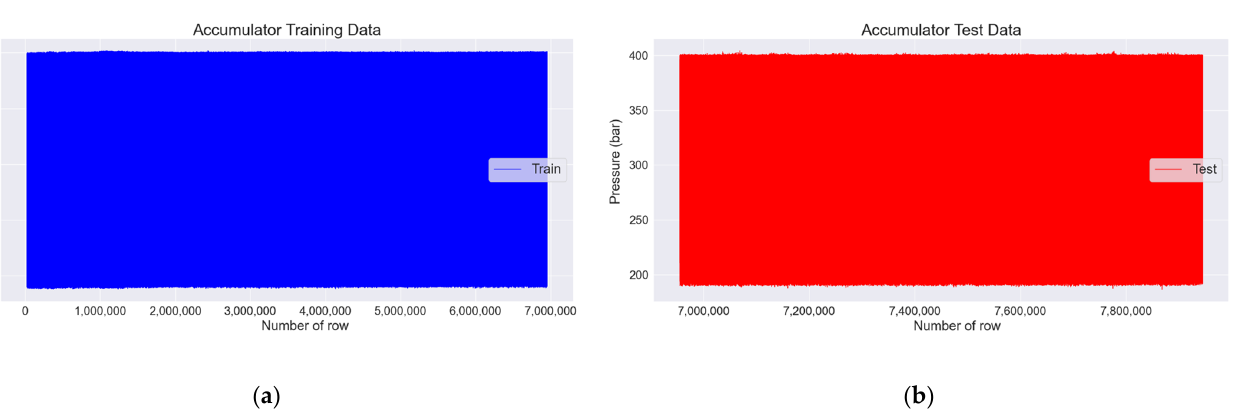
Figure 13. Visualization of pulsating pressure for training and test data. ( a ) Training data consisting of normal pulsating pressure; ( b ) test data consisting of abnormal pulsating pressure.